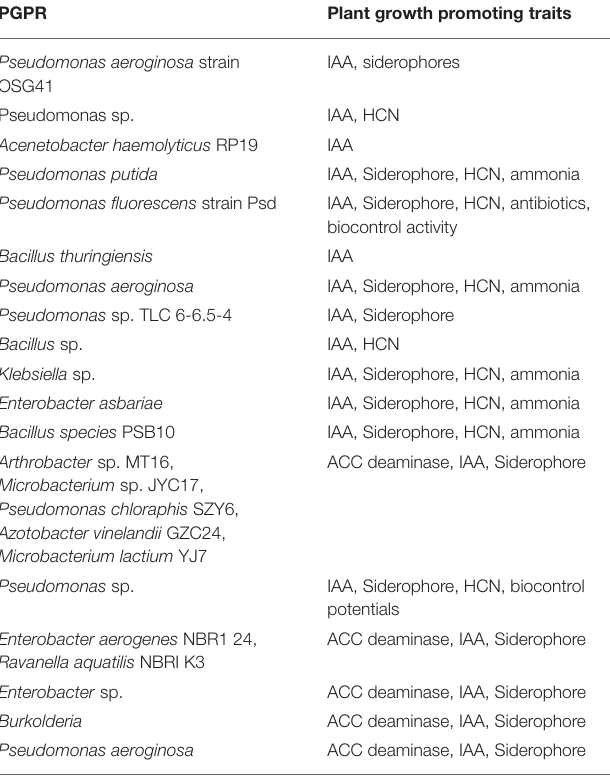
TABLE 7 | Plant growth promoting substances realeased by phosphate solubilizing bacteria (Source: Ahemad, 2015), Copyright 2018 Springer Nature. PGPR Plant growth promoting